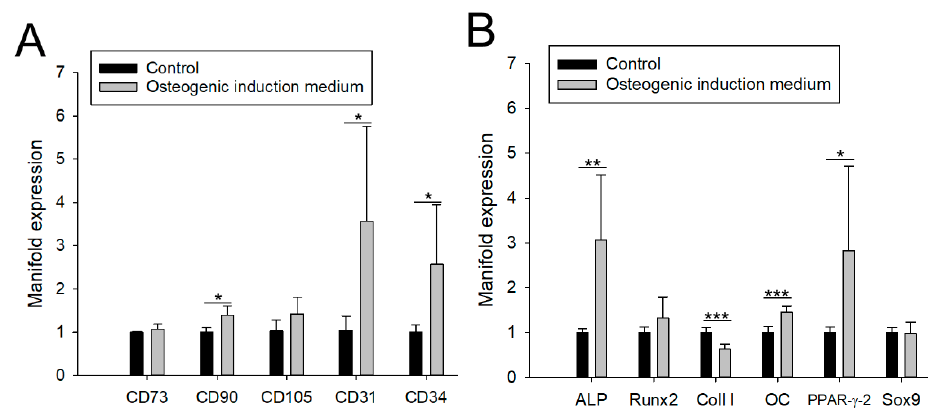
Figure A1. Average manifold induction of different genes. Experiments were carried out with osteogenic induction culture medium (see Section 2 for supplements) and 14 days in culture. Markers for stem cells, such as CD73, CD90 and CD105; and endothelial cells, such as CD31 and CD34, respectively ( A ) and markers for osteogenesis (ALP, Runx2, Collagen I and OC = osteocalcin), adipogenesis (PPAR- γ -2) and chondrogenesis (Sox9) ( B ) are shown. Results are given as means, and error bars denote standard deviations. Key: p < 0.05 (*); p < 0.01 (**) and p < 0.001 (***).